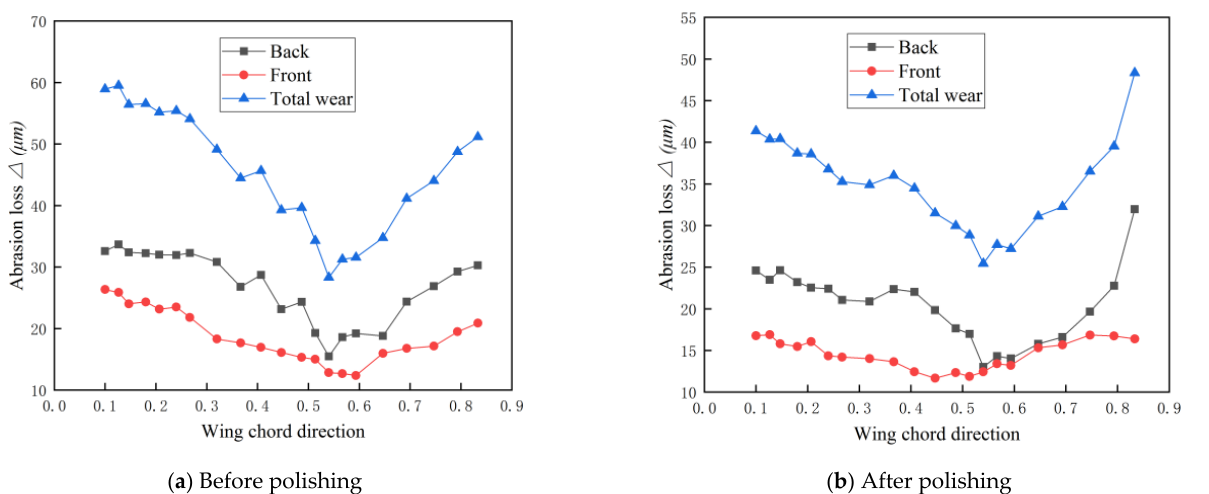
Figure 23. ( a , b ) Wear on the chord of different airfoil types ( P = 42.8 MW).